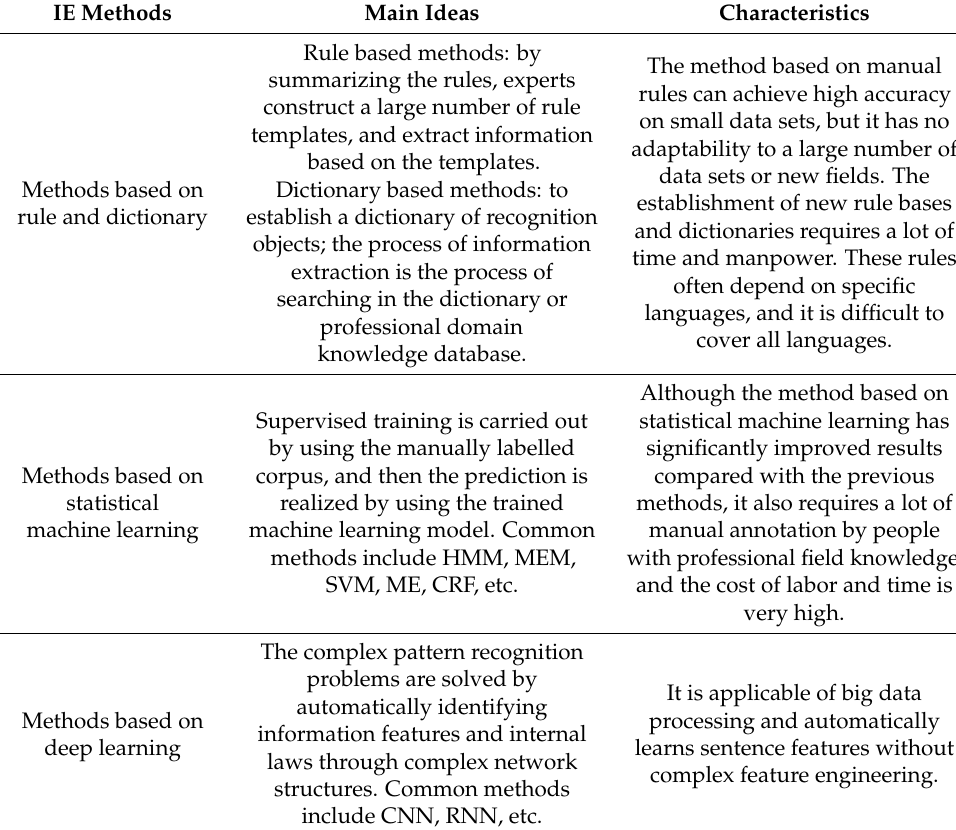
Table 1. The Development history of